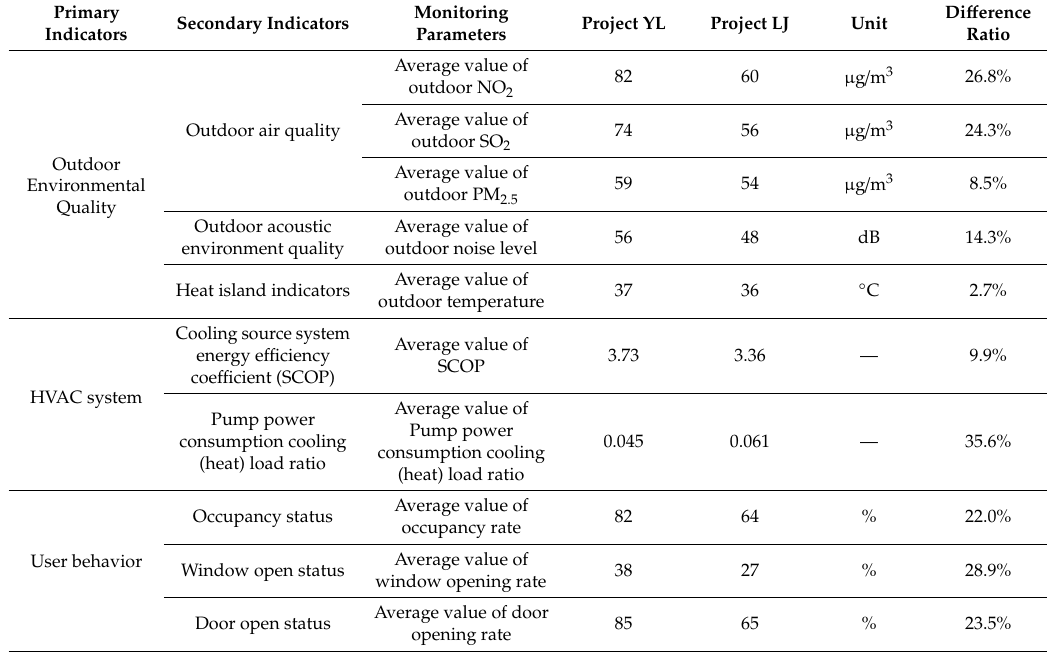
Table 13. The monitoring data of other key performance indicators for two case